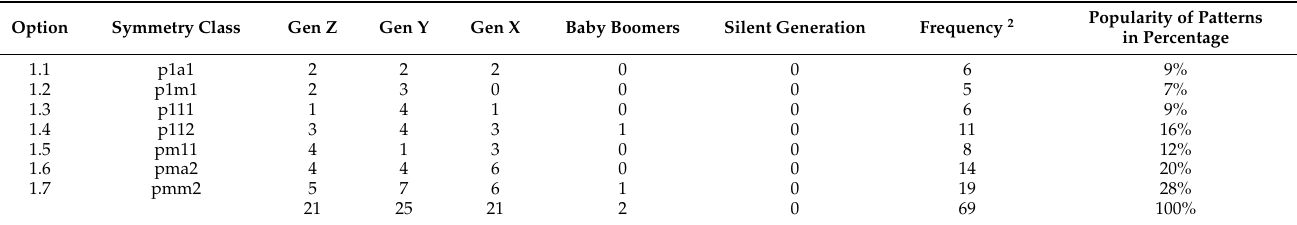
Table 3. Preferences 1 for frieze patterns from design approach